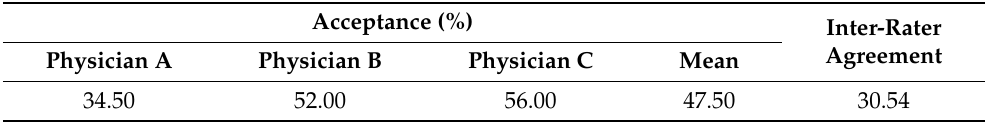
Table 4. Physician acceptance of drug